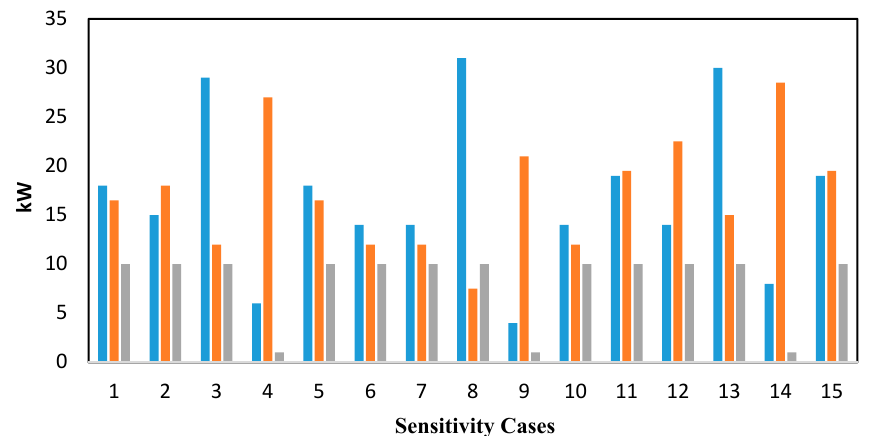
Figure 11. Size of HRES components with lowest NPC for all the sensitive cases.